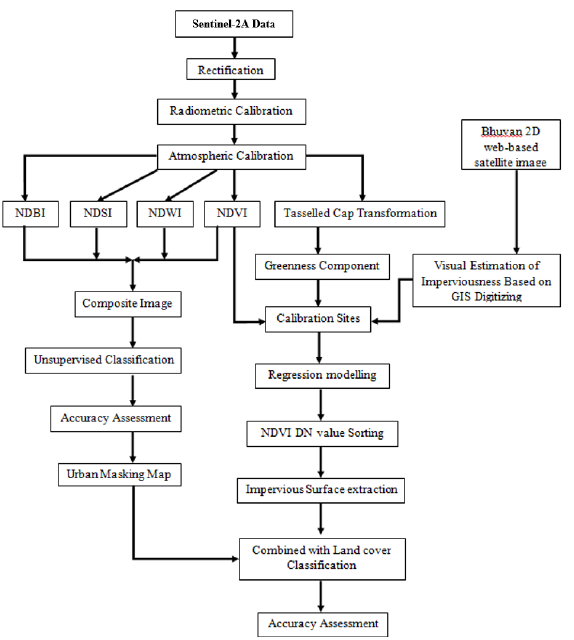
Figure 3 . Methodology for Impervious Mapping